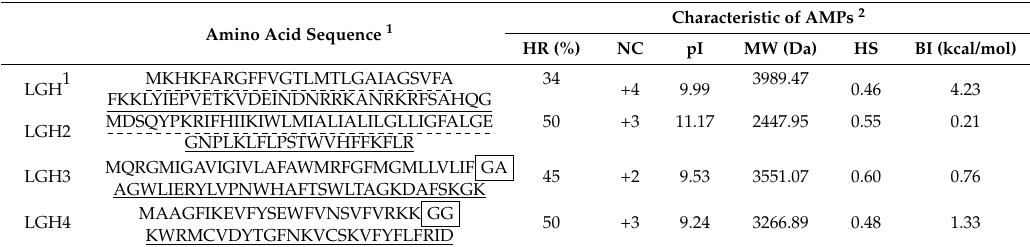
Table 1. Predicted AMPs from the genome of L. casei HZ1.